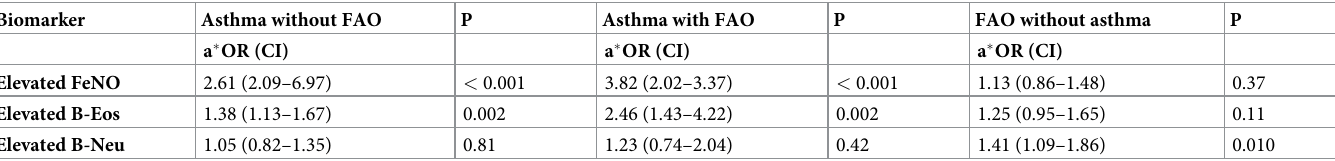
Table 4. Adjusted � odds ratios for elevated markers (FeNO � 25ppb, B-Eos � 300 cells/ μ L, B-Neu � 5100 cells/ μ L) for the asthma and FAO groups in relation to the control group in an adjusted logistic regression.